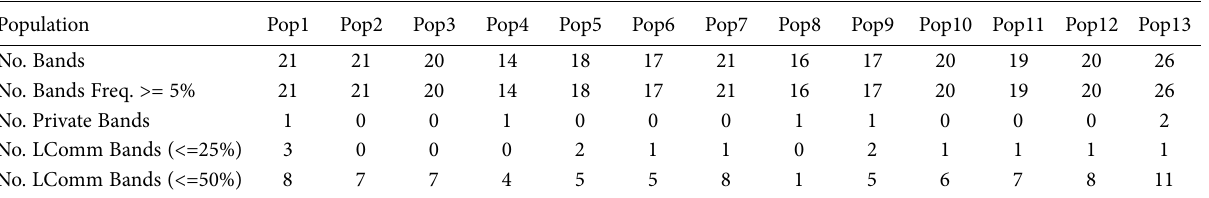
Table 7. Details of SRAP bands obtained in the studied populations of Ziziphus jujuba (populations numbers are according to Table 1). Population